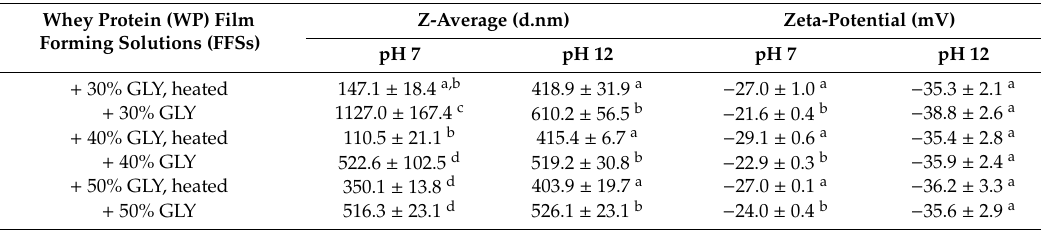
Table 1. Zeta-potential and Z-average measurements of whey protein (WP) film forming solutions (FFSs) prepared at pH 7 or 12 and subjected or not to heat treatment. Whey Protein (WP) Film Z-Average Forming Solutions (FFSs)